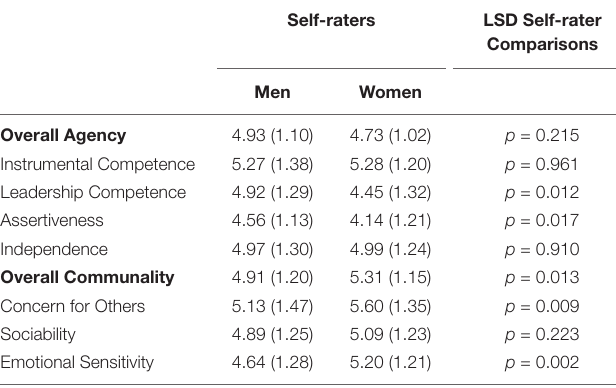
TABLE 6 | Means (and standard deviations) and LSD results of